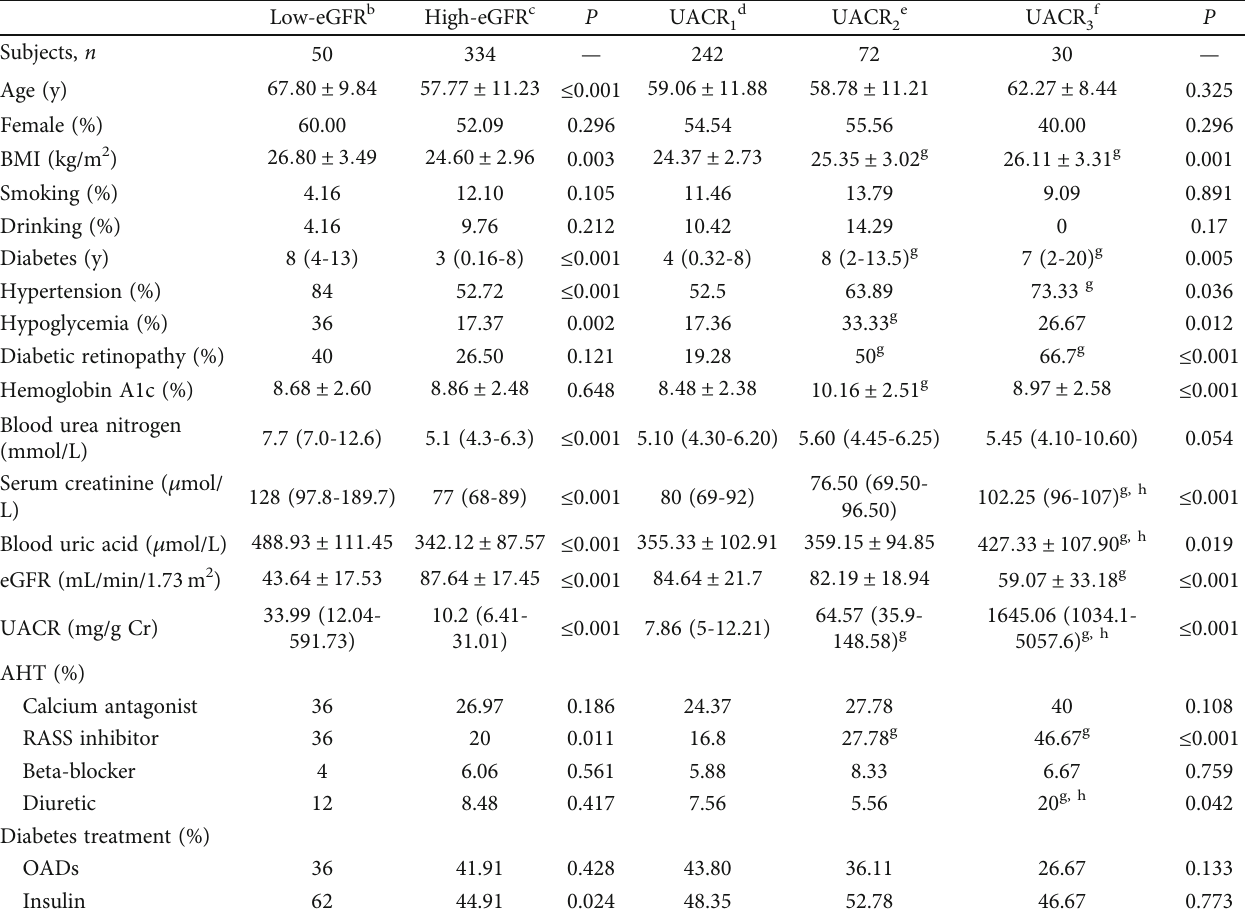
Table 1: Clinical characteristics of patients according to eGFR and UACR status a .